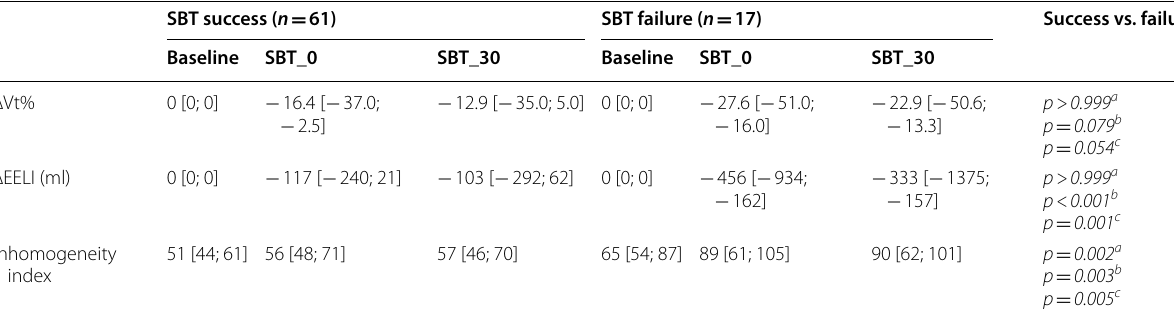
SBT: Spontaneous Breathing Trial; SBT_0: first 5 min after the beginning of the SBT; SBT_30: last 5 min of the SBT; ∆Vt%: change from baseline of the tidal volume in percentage; ∆EELI: change from baseline of the end-expiratory lung impedance a Comparison between groups within baseline b Comparison between groups within SBT_0 c Comparison between groups within SBT_30. According to Bonferroni correction, the threshold for statistical significance is p <